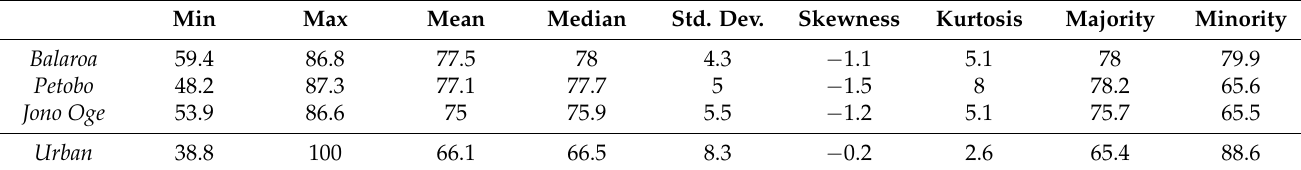
Figure 11. Damage assessment map vs. UNITAR database. Insets of urban and rural areas. Table 3. Comparing the damage assessment results of built-up areas in rural areas vs. the urban area by summarizing the